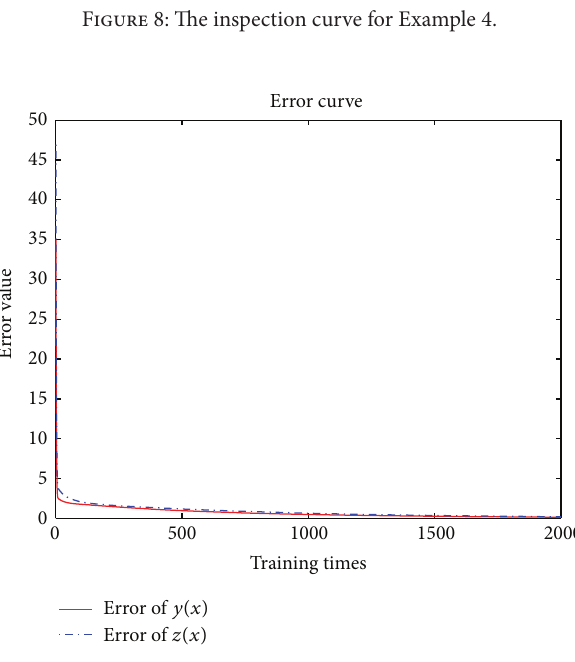
Figure 9: The error curve for Example